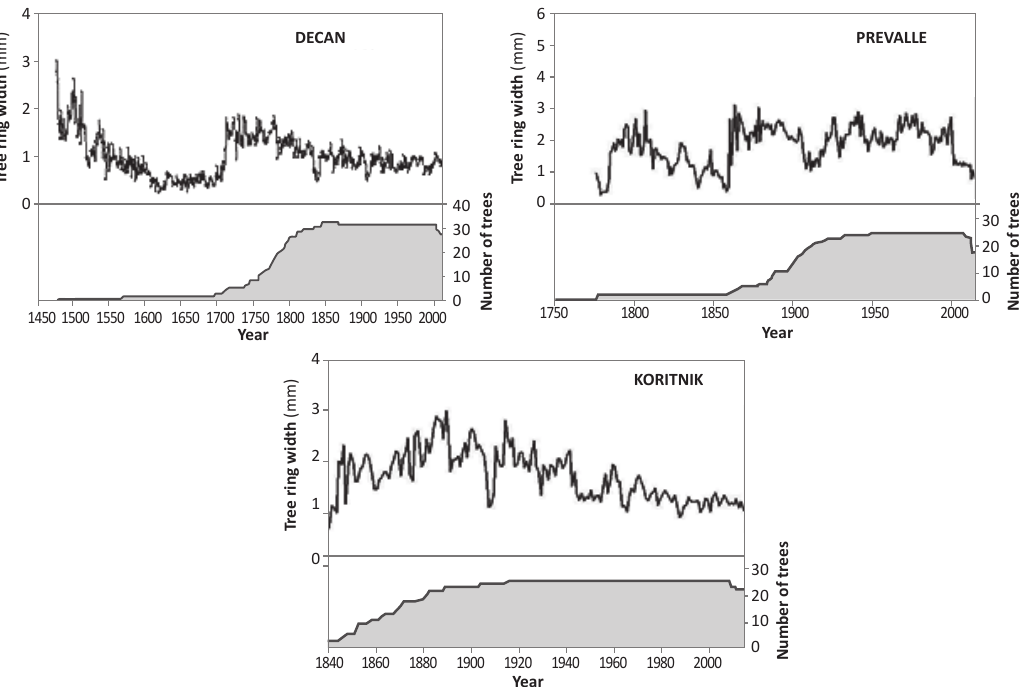
figURe 3. Raw tree-ring width chronologies of Bosnian pine ( P. heldreichii Christ.) from Decan, Prevalla and Koritinik. Upper part in each graph shows the raw tree-ring width chronology while lower part shows tree replication in respective site chronologies